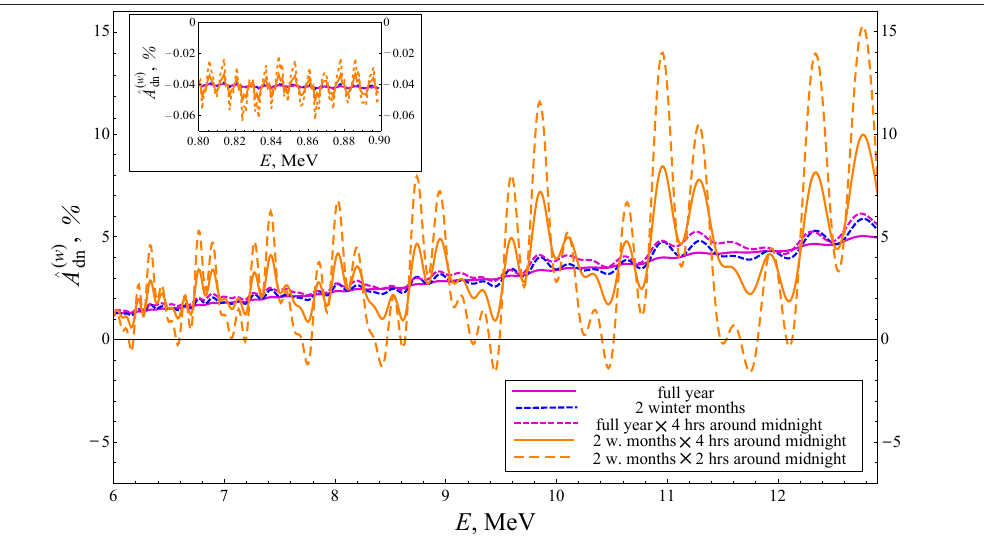
Figure 1. The ‘probabilistic’ asymmetry (7) versus the neutrino energy E depending on the observation time window for a detector at the latitude χ = 26 ◦ . Inset: the same for the energies of 7 Be neutrinos (around E = 0 . 862 MeV)